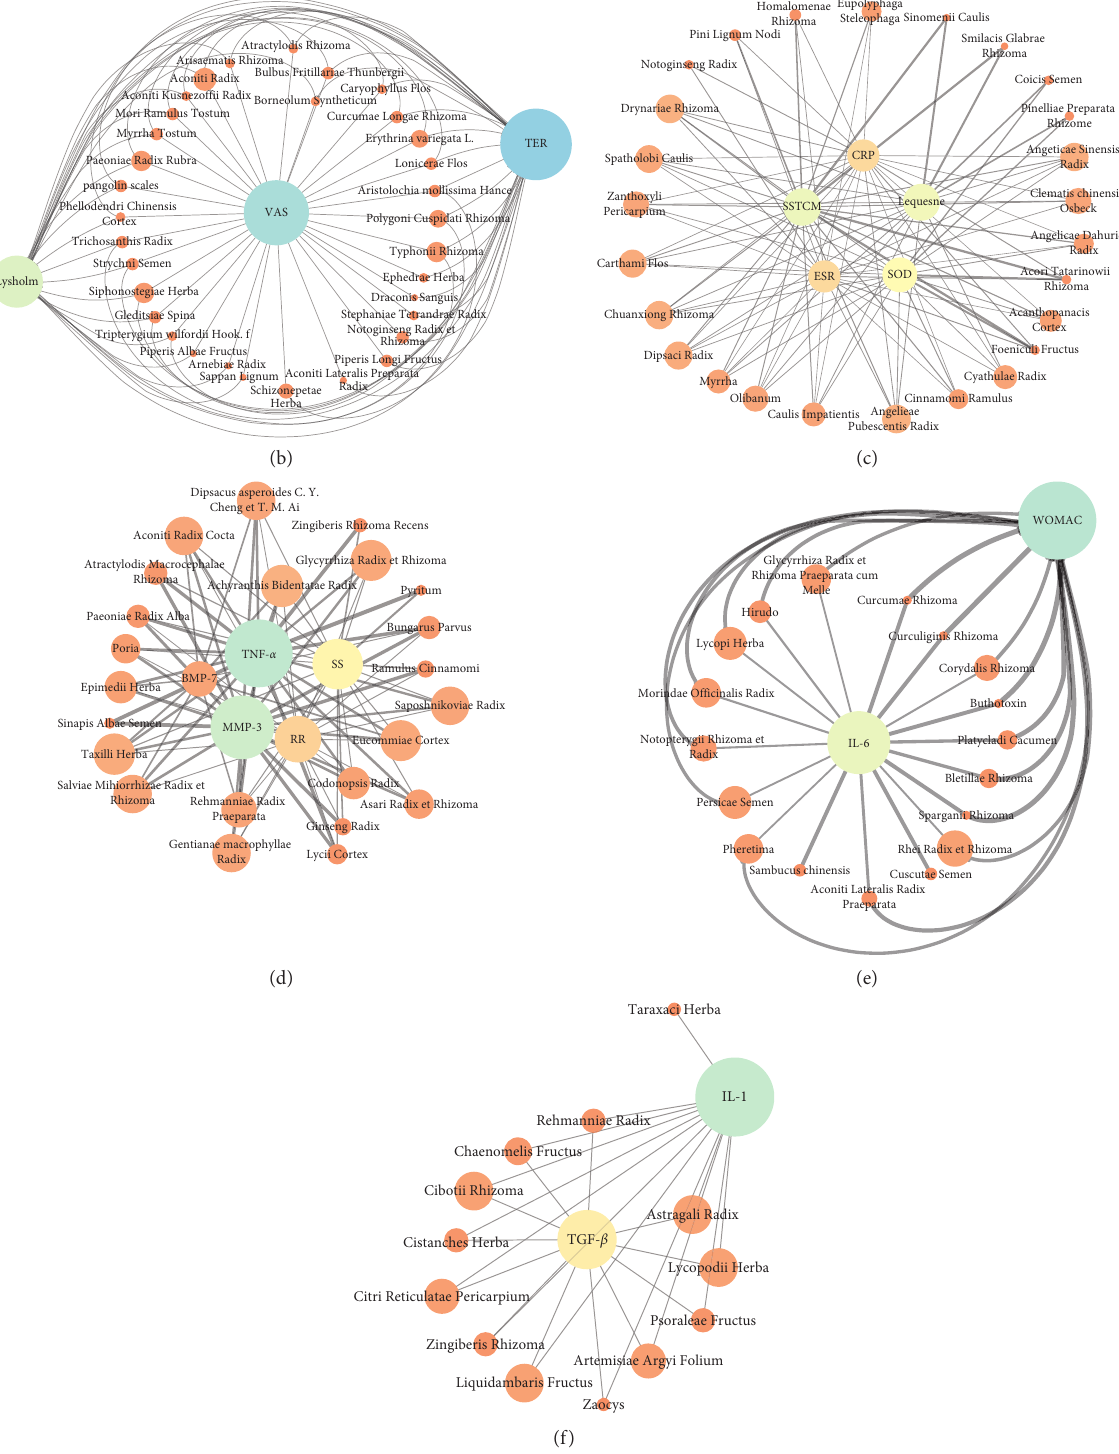
Figure 8: Corresponding relationship between TCMs and the index network. The larger nodes are represented by the main effectively reduce the content of IL-6 and then reduce the WOMAC. Figure 8(f) shows that Lycopodii Herba, Astragali Radix, and Liquidambaris Fructus significantly